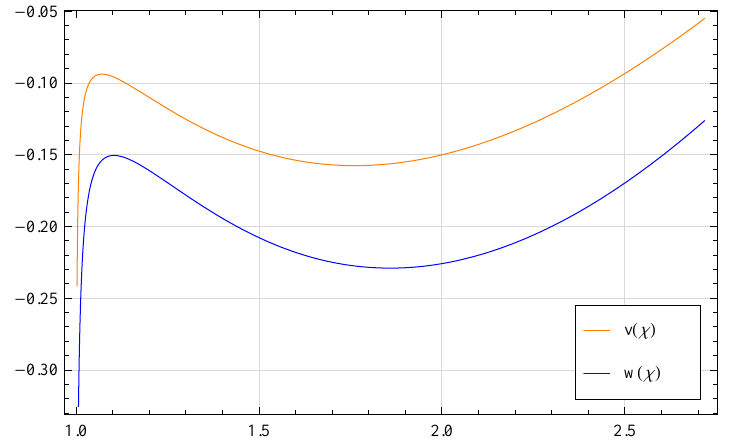
Figure 4. Sketch of solution in case (iv)